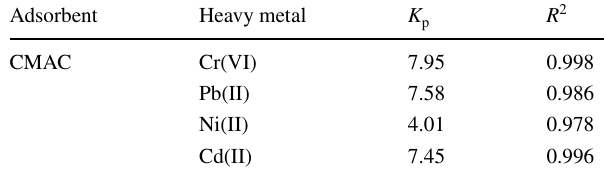
Table 6 Intraparticle diffusion rate equation